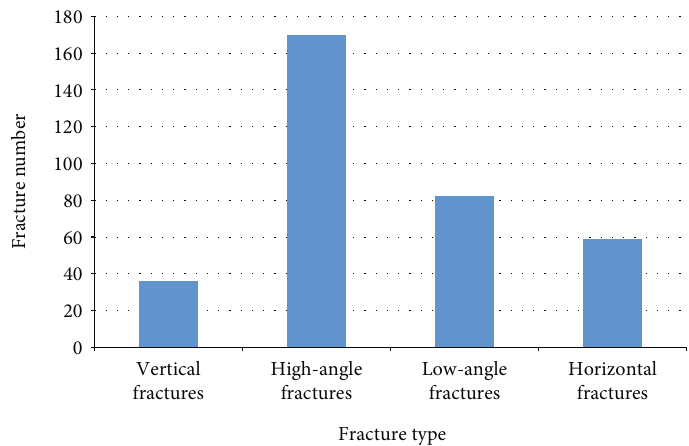
Figure 10: Type and number statistics of fractures